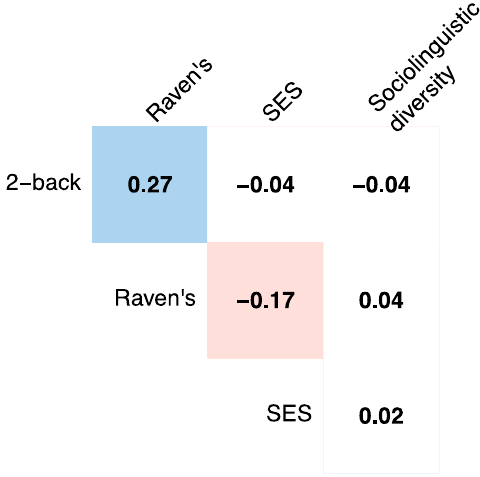
Figure 3. Correlation matrix presenting the correlations between the cognitive scores and the socio-economic and sociolinguistic diversity scores investigated in this paper (SES = socio-economic status). Correlations with a blue or pink background are statistically significant at a 0.01 level.